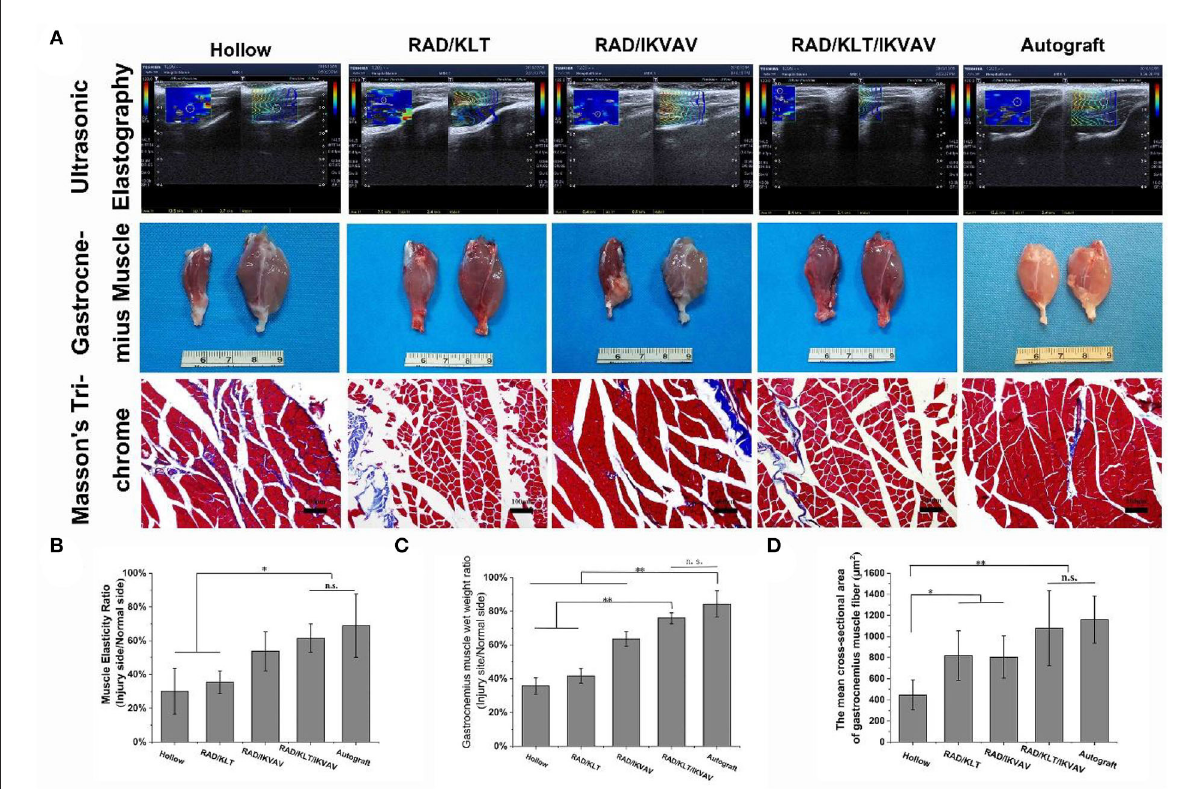
FIGURE8 (A) Ultrasonography of gastrocnemius at 6 weeks after surgery. Gross images of the isolated gastrocnemius muscles and the Masson’s trichrome staining images of the transverse sections of muscles from the injured limbs at 12 weeks after implantation. Statistical analysis of the muscle elasticity ratio (B) , the gastrocnemius muscle wet weight ratio (C) , and the percentage of muscle fiber area (D) . Values represent mean ± SD; n.s. no significant difference, ** p < 0.01, * p < 0.05 in multiple comparisons between treatment